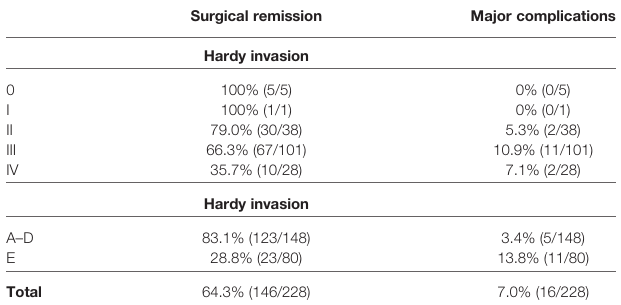
TABLE 5 | Surgical outcome based on the invasion and extension Hardy classi fi